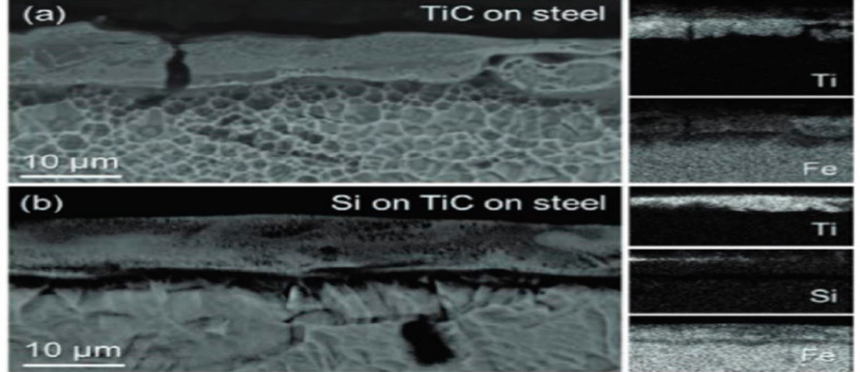
Figure 15. Images of coating cross-sectional showing BSE and EDX maps of ( a ) TiC layer and ( b ) TiC + Si coating layer [148].